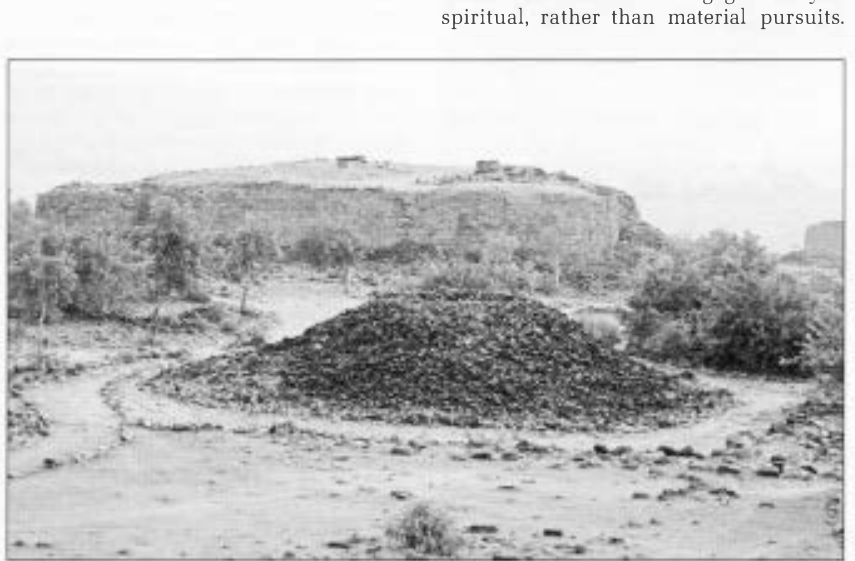
Figure 5 The base of a large monastery at More] khurd, originally surmounted by brick and stone superstructure. A heavily damaged stupa is visible in the foreground. Both are datable to c. second century